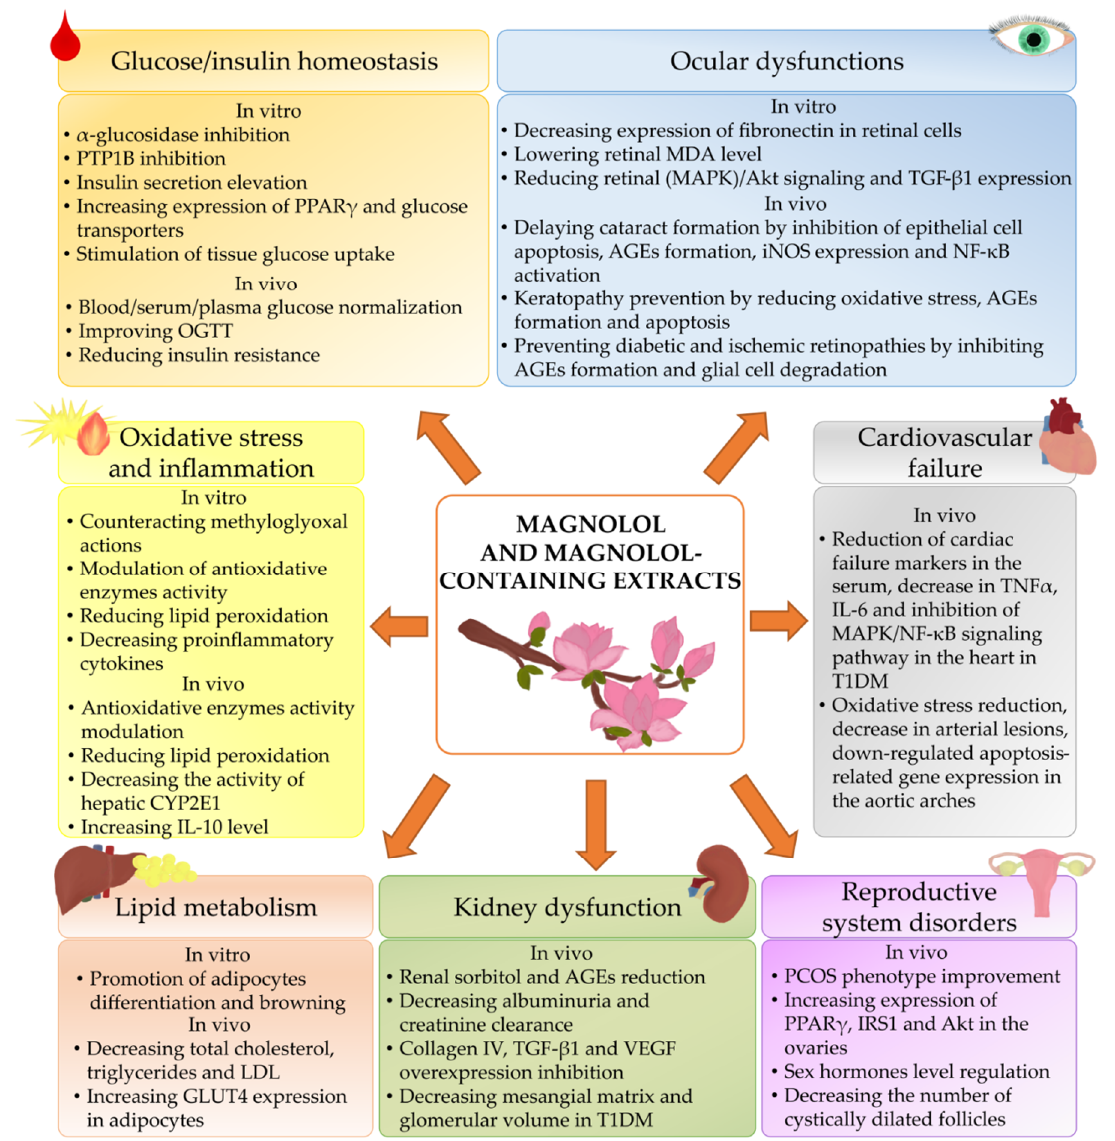
Figure 2. Effect of magnolol and magnolol-containing extracts on diabetes and diabetes-related condition. AGEs, advanced glycation end products; Akt, protein kinase B; CYP2E1, cytochrome P450 2E1; GLUT4, glucose transporter 4; IL-6, interleukin 6; IL-10, interleukin 10; iNOS, induced nitric oxide synthase; IRS1, insulin receptor substrate 1; LDL, low-density lipoprotein; MAPK, mitogen-activated protein kinase; MDA, malondialdehyde; NF- κ B, nuclear factor kappa-light-chain-enhancer of activated B cells; OGTT, oral glucose tolerance test; PCOS, polycystic ovary syndrome; PPAR γ , peroxisome proliferator- activated receptor gamma; PTP1B, protein tyrosine phosphatase-1B; T1DM, type 1 diabetes mellitus; TGF- β 1, transforming growth factor β 1; TNF α , tumor necrosis factor α ; VEGF, vascular endothelial growth